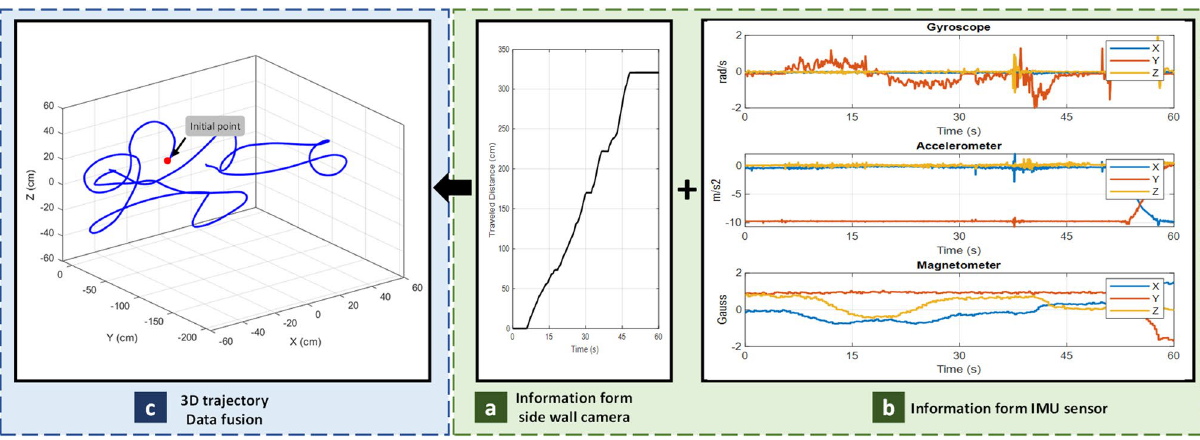
Figure 19. Validation